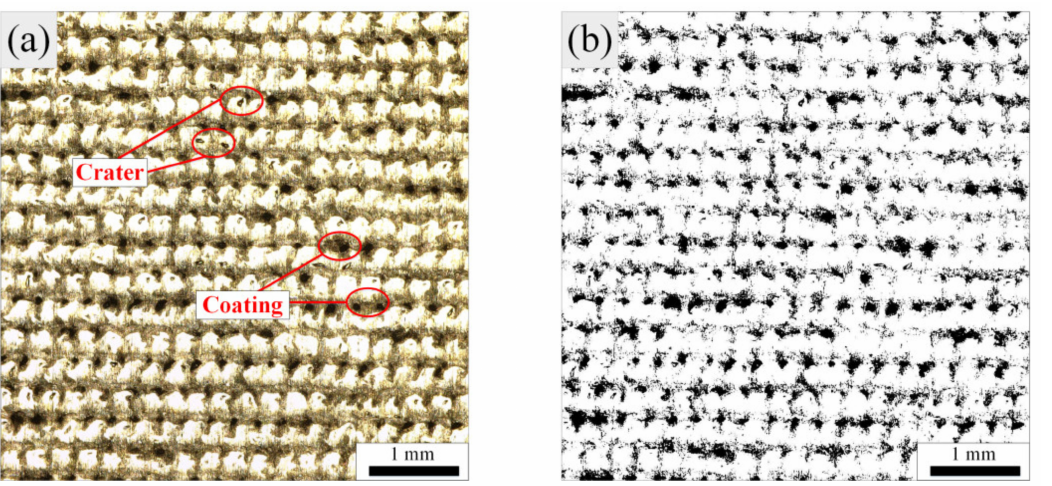
Figure 4. Water jet-guided laser cleaning area and its binarization comparison chart. ( a ) Color photo; ( b ) Binarized